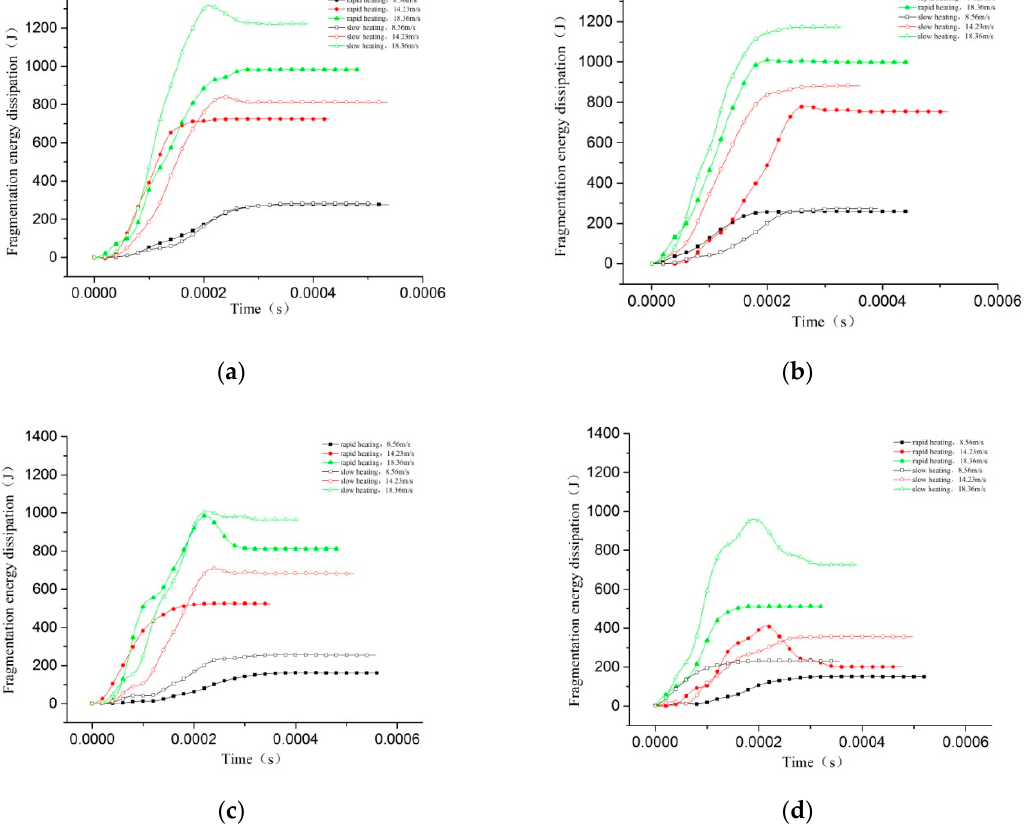
Figure 15. Energy dissipation curve under different temperature gradient conditions. ( a ) 200 °C; ( b ) 400 °C; ( c ) 600 °C; ( d ) 800 °C.